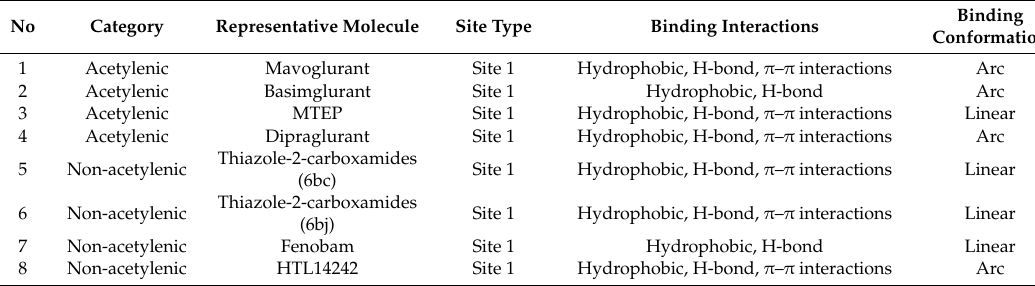
Table 4. Interaction features of representative mGluR5 NAMs.